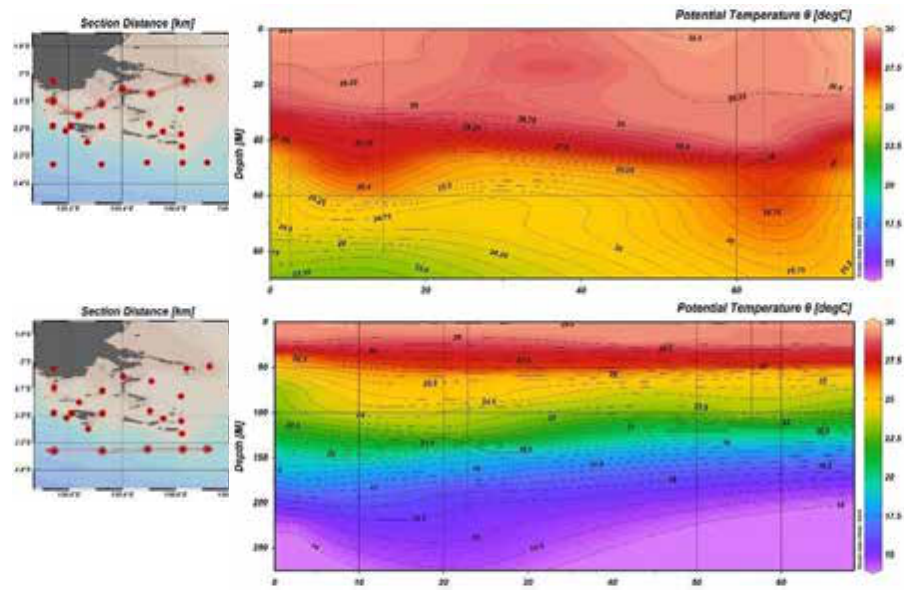
Fig. 3: The observation of spatial vertical temperature of Misool waters